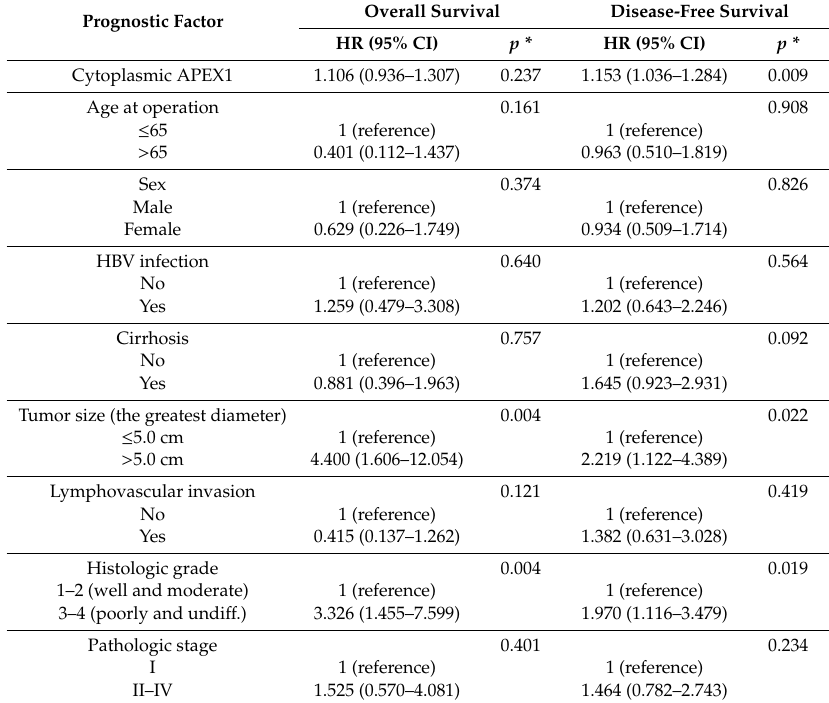
Table 5. Multivariate analysis of overall survival and disease-free survival in 131 patients with primary hepatocellular carcinoma